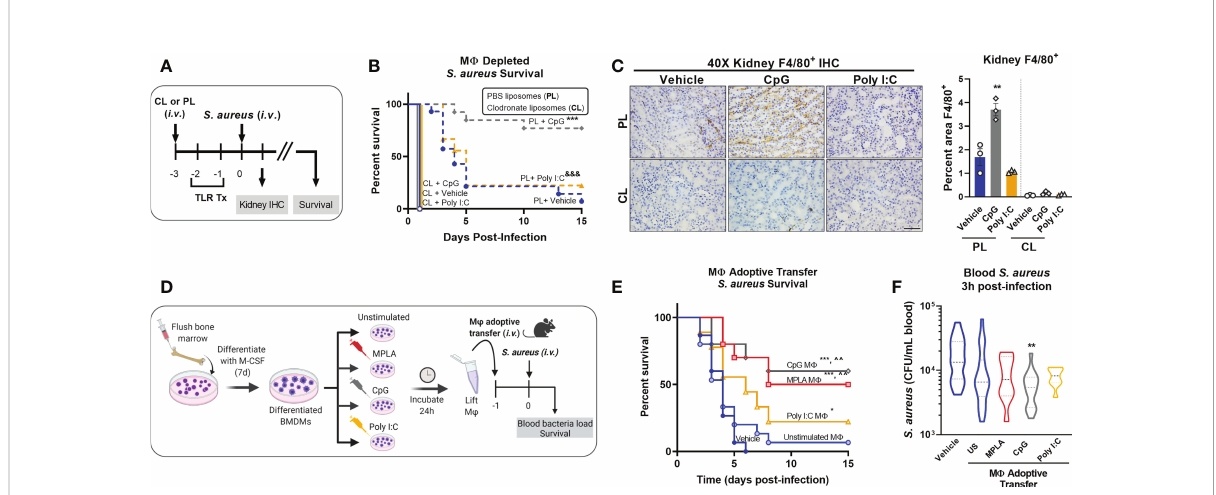
FIGURE 2 Macrophages are critical for CpG-mediated host resistance to S. aureus infection. (A) Mice were injected ( i.v. ) with clodronate liposomes (CL) or control PBS liposomes (PL) 24h prior to the fi rst injection of TLR agonist or vehicle. Mice were administered CpG, Poly I:C, or vehicle for two consecutive days ( i.v. ), and challenged with 10 8 CFU S. aureus ( i.v. ) the following day. (B) Survival was monitored for 15 days. (C) Representative images of F4/80 IHC staining of kidney samples harvested 1-day post-infection of macrophage-depleted (CL) or control (PL) mice are shown (scale bar represents 50 m m); F4/80 IHC was (right, n = 3/group). (D) Bone marrow-derived macrophages (BMDMs; M F ) were treated with MPLA (1 µg/mL), CpG (1 µg/mL), or Poly I:C (10 µg/mL) for 24h or left unstimulated (US), washed, and transferred (5X10 5 i.v. ) to otherwise naïve mice 24h prior to systemic challenge with 10 8 CFU S. aureus. (E) Survival after S. aureus infection in macrophage recipient mice alongside vehicle- treated controls (n=9-15/group) was monitored for 15 days. (F) Bacteremia was assessed 3h post-infection. Bars represent mean ± SEM. ***p < 0.001 compared to CL + Vehicle and &&& p < 0.001 compared to CL + Poly I:C (B) , *p < 0.05 and ***p < 0.001 compared to vehicle or ^^compared to unstimulated macrophages (E) by a log-rank Mantel – Cox test for Kaplan – Meier survival plots; ** p < 0.01 compared to vehicle controls determined by ANOVA followed by Dunnett ’ s post-hoc multiple comparison